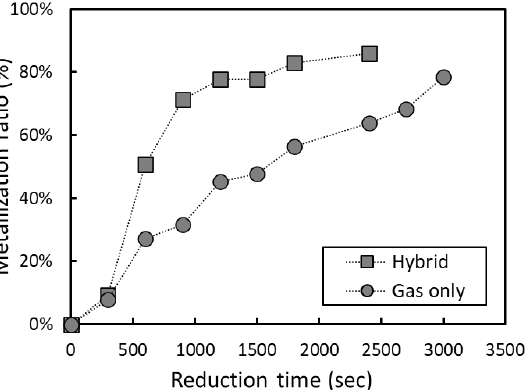
Figure 11. Comparison of metallization ratio for combined reduction and reduction by CO gas.